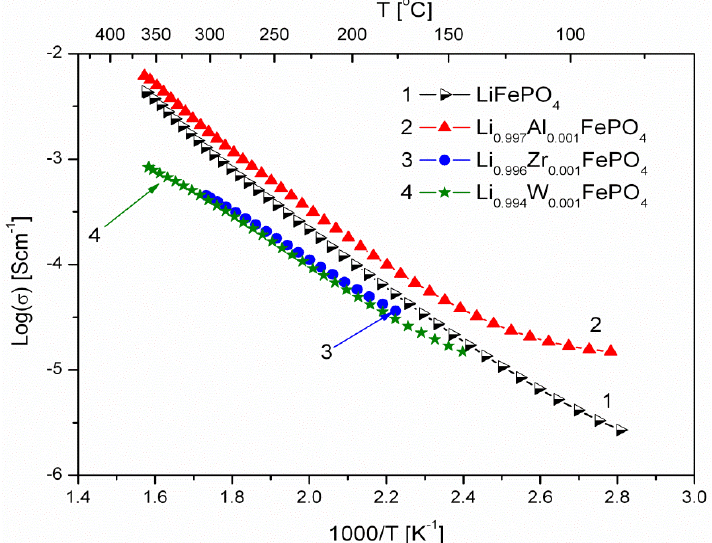
phosphoolivines with x = 0.001 mol mol − 1 .